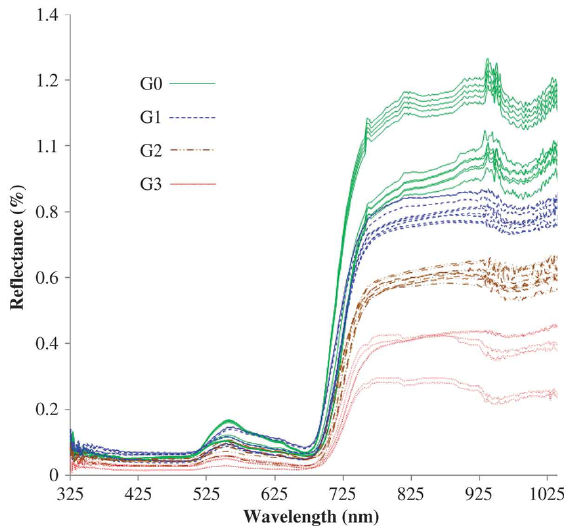
Figure 3. Reflectance spectra of healthy (G0) and non-healthy (G1, G2 and G3) leaf samples